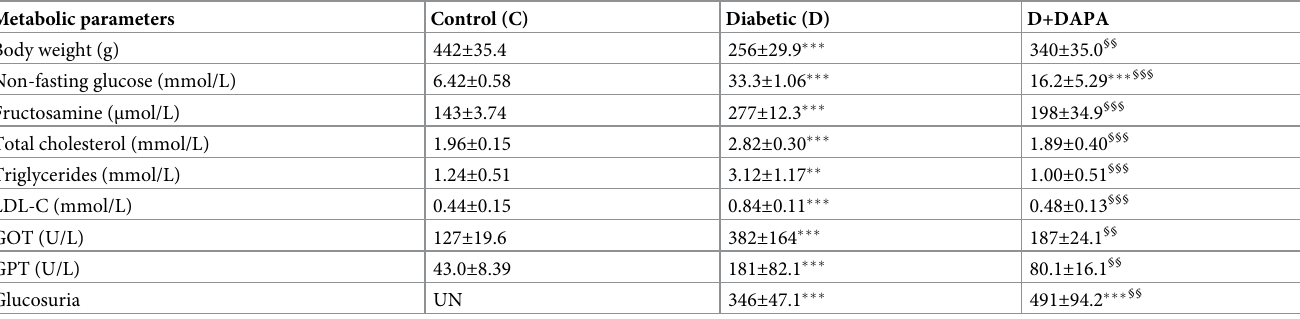
C, Control; D, diabetic; D+DAPA, dapagliflozin-treated diabetic; LDL-C, low-density lipoprotein cholesterol; GOT, serum glutamate-oxaloacetate transaminase; GPT, serum glutamate-pyruvate transaminase; p values indicate means ± SDs and data were analyzed by one-way ANOVA with Holm-Sidak multiple comparisons test (n = 6 /group). �� p < 0.01 vs .